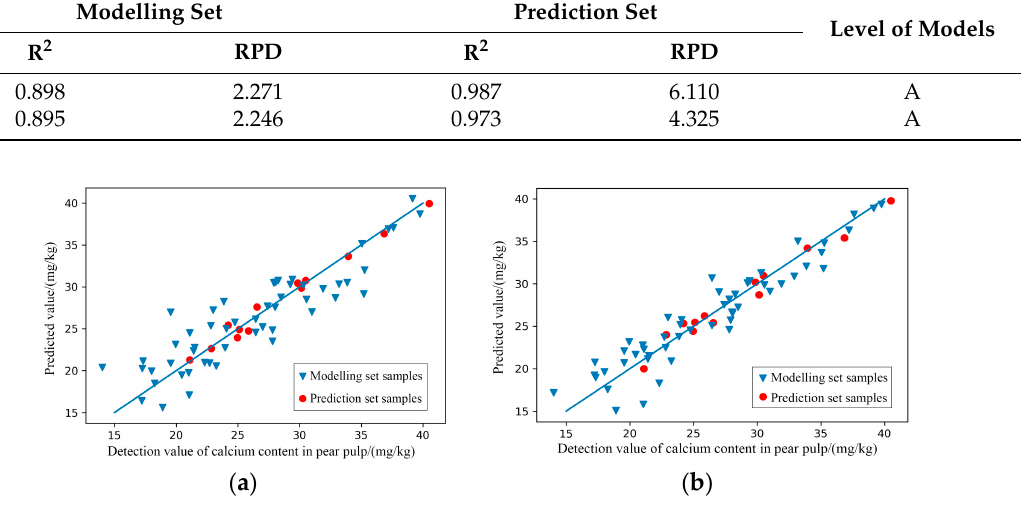
Figure 7. Scatter plots of models’ prediction results of the content of calcium in pear pulp samples. ( a ) Raw-GA-PLSR; ( b )